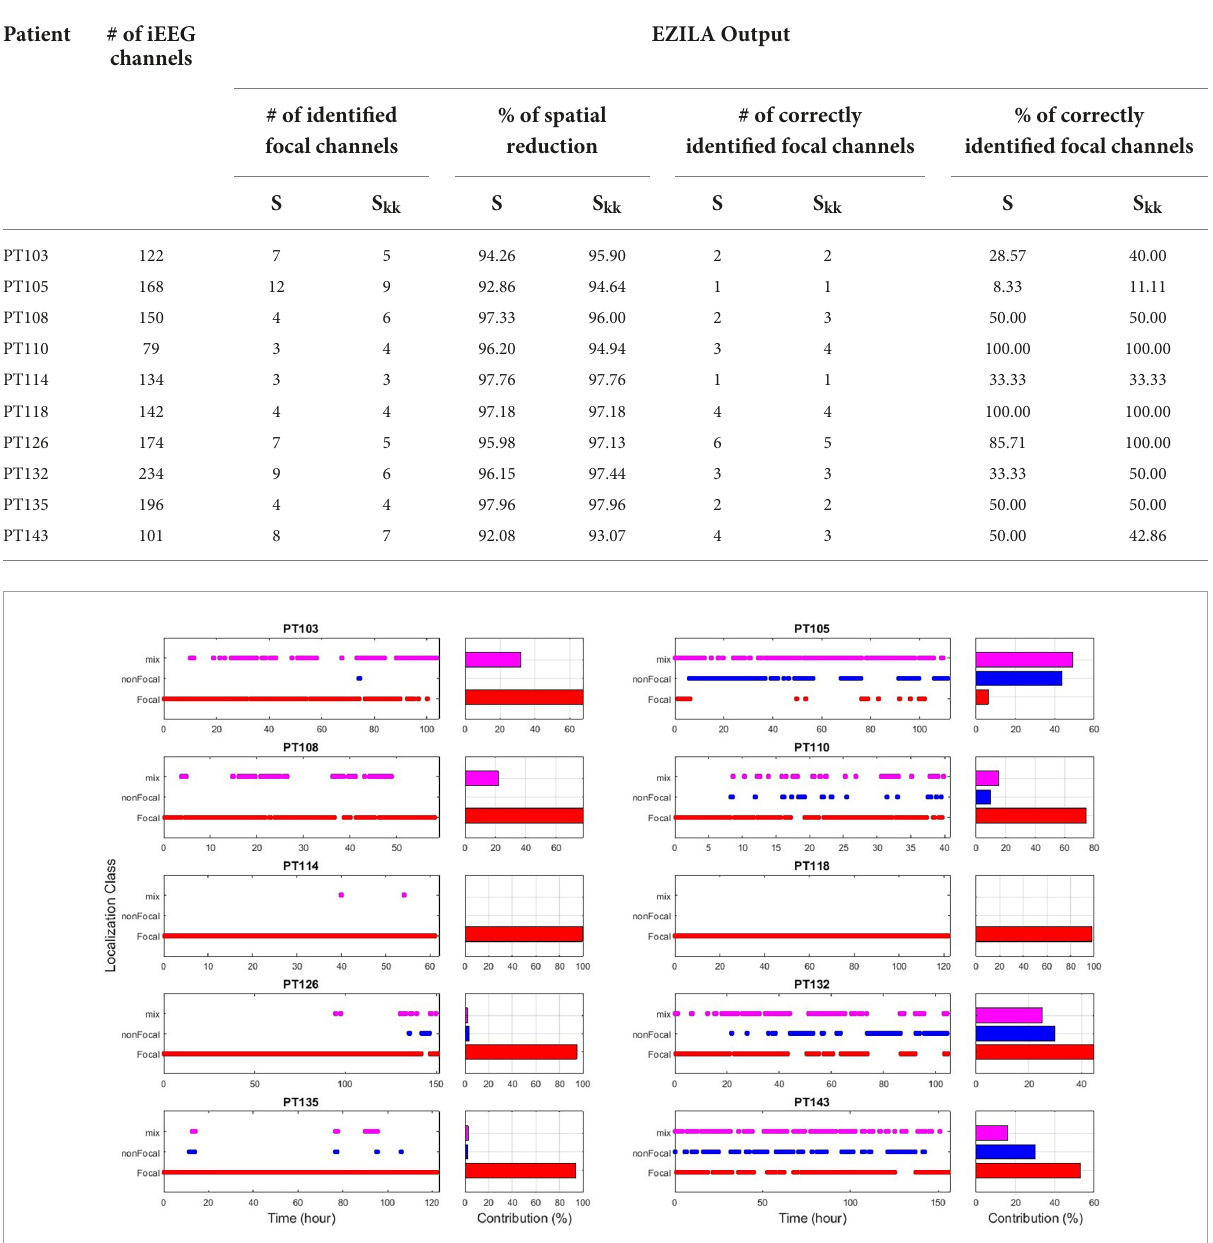
FIGURE8 EZ interictal localization algorithm (EZILA) results overtime via non-overlapping 10 min windows per patient using the periodogram measure. Each time-window is classified as either a focal (red), non-focal (blue), or mix (violet) window based on channel(s)